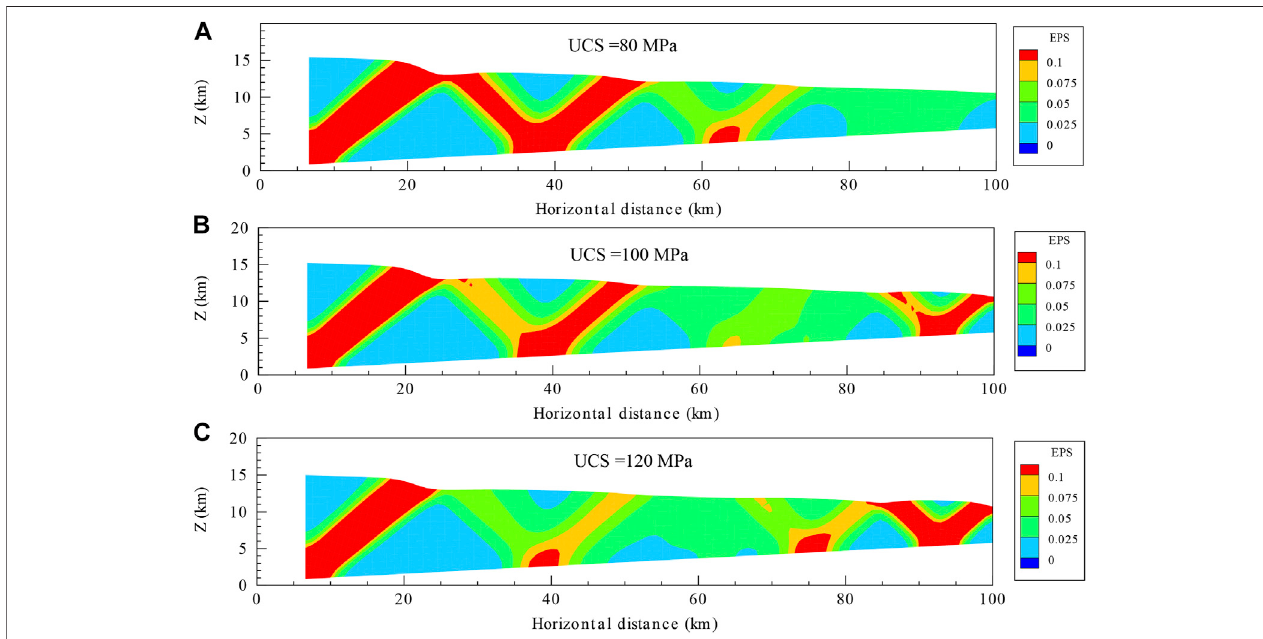
FIGURE 9 | Final state EPS for models with different uniaxial compressive strength (UCS). After 6.6 km of shortening displacement, panels (A – C) show states of models 4, 5, and 6, which have uniaxial compressive strengths of (80, 100, and 120) Mpa, respectively. Plasticity concentration patterns are different among them. Higher strengths tend to decrease extent and intensity of plasticity in wedge ’ s thick region, while slightly favoring it in its thin region.